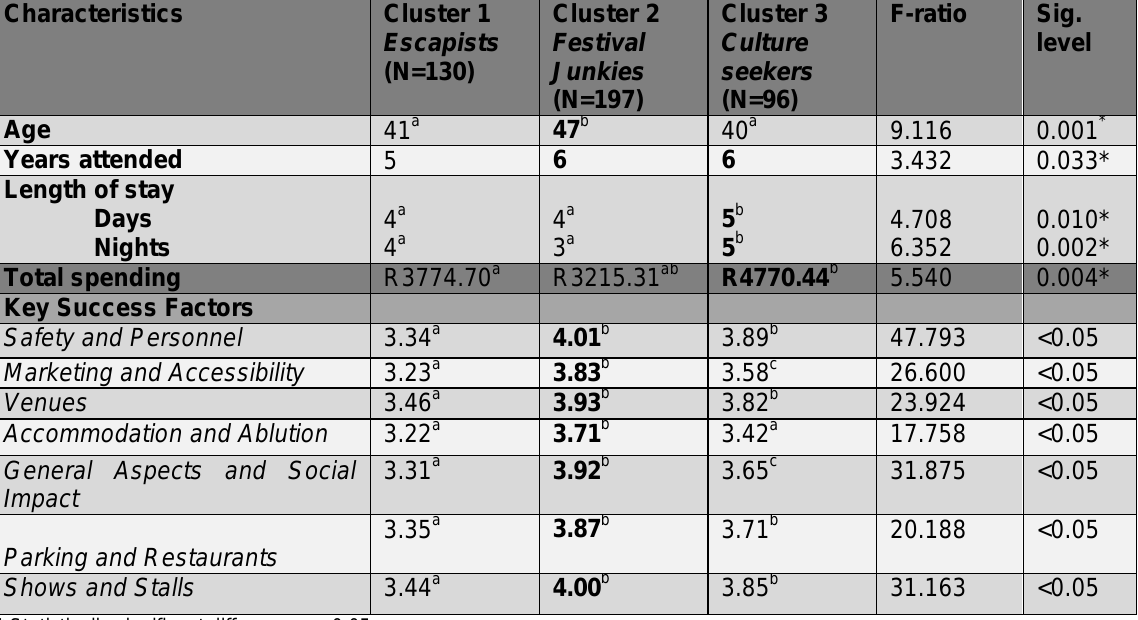
Table 4: ANOVA and Tukey’s post hoc multiple comparison results for visitor characteristics and key success factors of the